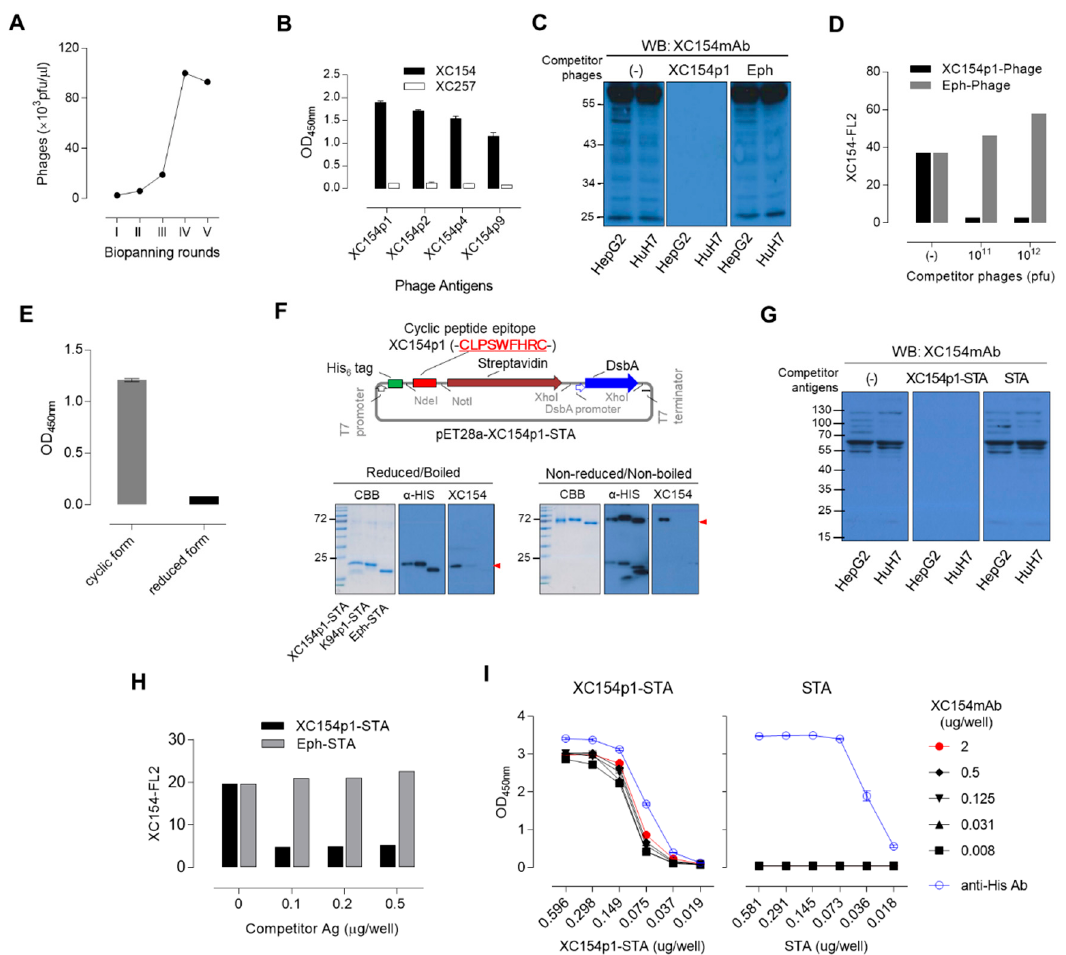
Figure 3. Anti-ATIC autoantibody ELISA was set up using XC154p1-STA for the specific and sensitive detection of autoantibodies in human sera. ( A ) Bio-panning with XC154 antibody against phage-displayed random cyclic heptapeptide library. ( B ) Phage ELISA to confirm the specific binding of selected mimotopes against XC154. XC257, another autoantibody was compared as a non-related control. Coating phages were 10 11 pfu phages per well. Primary antibody XC154 mAb was used at the concentration of 0.1 µ g / well. ( C ) Competitive Western blot analysis on the specific binding of XC154p1 phage to XC154 mAb. The amount of protein loading was 40 µ g / lane, and XC154 mAb (5 µ g / 10mL) was pre-incubated with each phage (10 12 pfu). ( D ) Competitive FACS assay of XC154p1 phage to evaluate specific binding of XC154 antibody to HepG2 cells. 1 × 10 5 cells were reacted with XC154 mAb (0.5 µ g / reaction), and competitive phages were pre-incubated with each phage as indicated in the plot. ( E ) The disappearance of XC154 antibody specific binding by linearizing XC154p1 cyclic peptide mimotope. ( F ) Expression vector of XC154p1 cyclic peptide-fused STA (XC154p1-STA). The purified XC154p1-STA antigen was analyzed by SDS-PAGE and Western blotting to confirm its tetrameric status. The monomer forms of STA antigens were confirmed by the analysis of reduced as well as boiled antigens. Purified protein loading amount 5 or 0.5 µ g / lane (immunostaining with anti-His antibody ( α -HIS) or XC154 autoantibody (XC154)). ( G ) Competitive Western blot analysis on the specific binding of XC154p1-STA to XC154 mAb. The cell lysates were loaded 40 µ g / lane, and XC154 mAb (5 µ g / 10mL) was pre-incubated with XC154p1-STA or STA (2 µ g). ( H ) Competitive FACS assay of XC154p1-STA to evaluate specific binding of XC154 antibody to HepG2 cells. 1 × 10 5 cells were reacted with XC154 mAb (0.5 µ g / reaction), and competitive antigens were pre-incubated with each antigen (XC154p1-STA or STA) as indicated in the plot. ( I ) XC154p1 epitope ELISA with XC154p1-STA antigen. Antigen was coated as indicated amount and detected with gradually diluted XC154